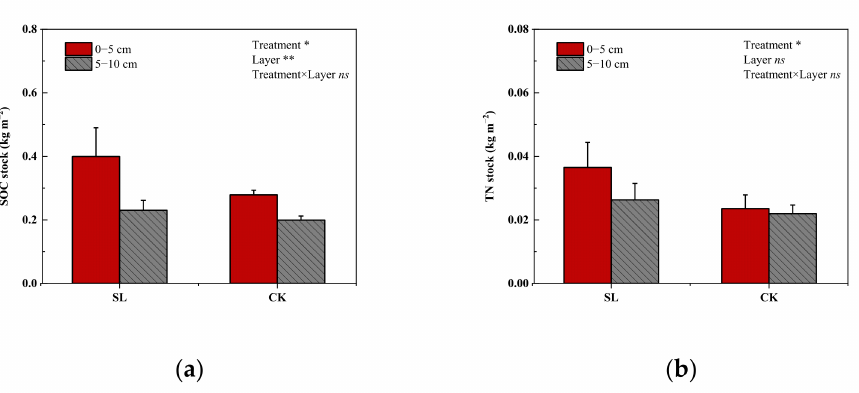
Figure 5. Comparison of ( a ) SOC stocks and ( b ) soil TN stocks between sewage sludge (SS) application (SL) and without SS application (CK) at depths of 0–5 cm and 5–10 cm in a Mongolian pine plantation. The values are the mean ± SD ( n = 3). ** p < 0.01; * p < 0.05; ns , not